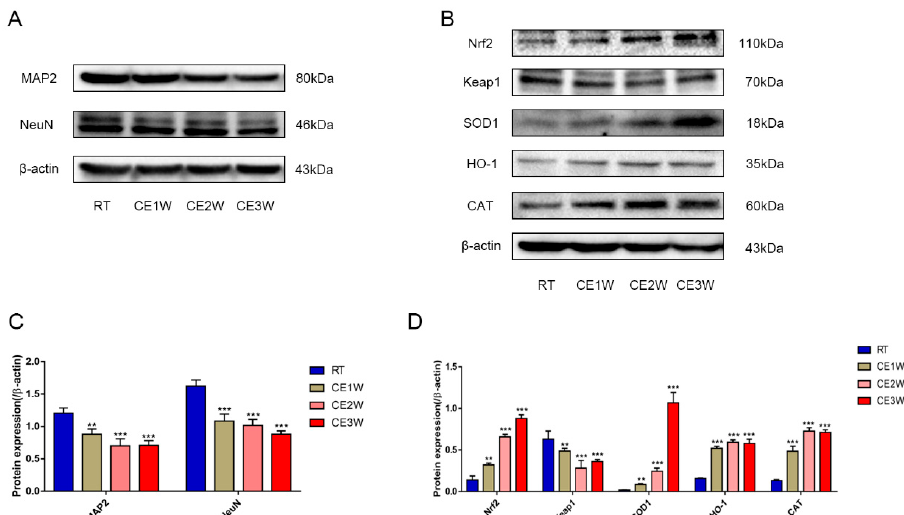
Figure 2. The function and target protein expression levels of anti-oxidative proteins in the anti-oxidative signaling pathway and markers of neuron-specific nuclear and dendritic tissues in hippocampal lysates as assessed by Western blotting and relative density analyses. ( A ) MAP2 and neuronal expression (NeuN). ( B ) Nrf2, Keap1, superoxide dismutase 1 (SOD1), heme oxygenase (HO-1), and Catalase (CAT) and β -actin (control) expressions in each group. The expression levels of each protein was quantitated by measuring the band intensities using Image Lab software. The graphs indicate densitometric analyses using the expression ratios of ( C ) MAP2 and NeuN/ β -actin, and ( D ) Nrf2, Keap1, SOD1, HO-1, and CAT/ β -actin. Data were between RTM vs. CE1W, CE2W and CE3W groups and were analyzed by one-way analysis of variance. The results are expressed as the mean ± SD ( n = 6) of four independent groups. ** p < 0.01; *** p < 0.001.